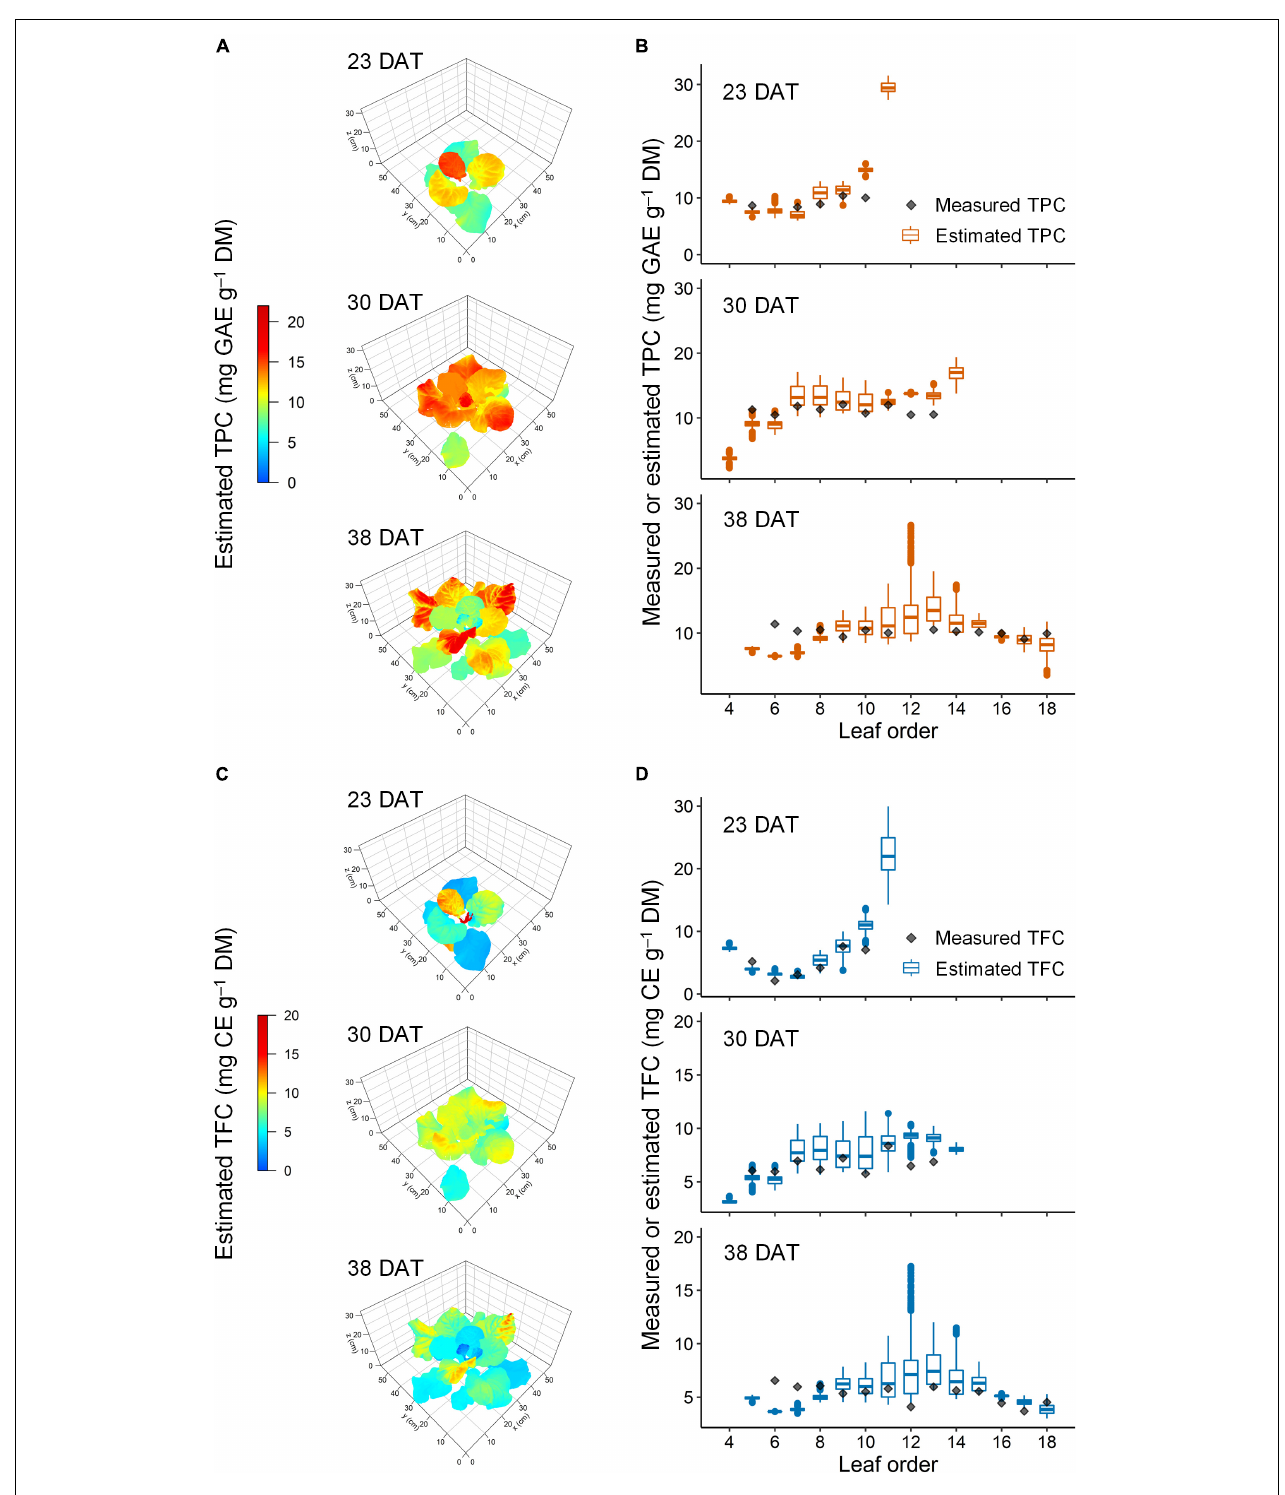
FIGURE 8 | Representative estimated distribution of total phenolic content (TPC, A,B) and total flavonoid content (TFC, C,D) in the leaves of kale plants under 12-h UV-B exposure at 23, 30, and 38 days after transplanting (DAT). The multiple regression models refer to in Figure 4 and Table 1 , and the 3D-scanned plant model refers to in Figure 3